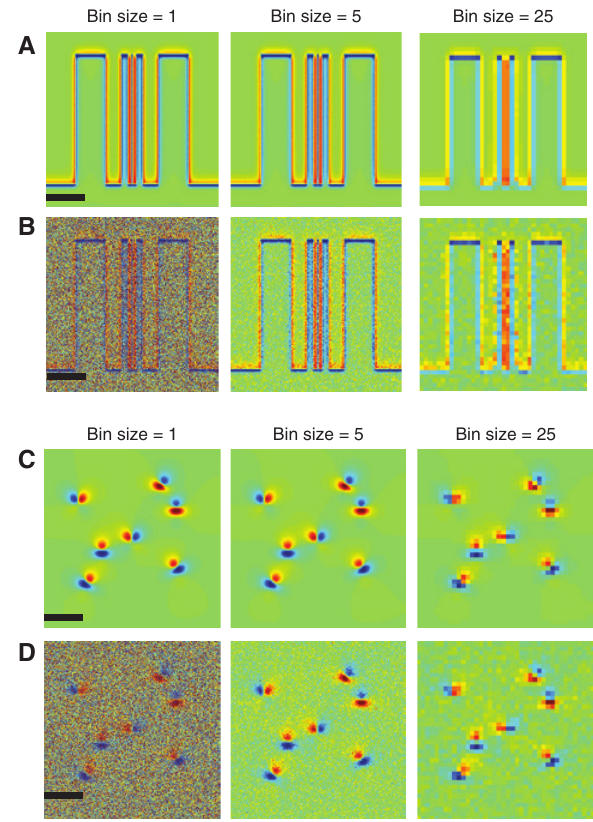
Figure 13: QDM spatial resolution and SNR tradeoff. (A) Magnetic field from the current distribution in Figure 4A for different planar binning sizes. No additional noise is applied. Scale bar is 50 μ m. (B) Binning with fractional noise leading to SNR of 1 for a bin size of 1. (C) Magnetic field from magnetic dipole sources in Figure 4B. No additional noise is applied. Scale bar is 10 μ m (B) for different planar binning sizes. (D) Binning with fractional noise leading to SNR of 1 for a bin size of